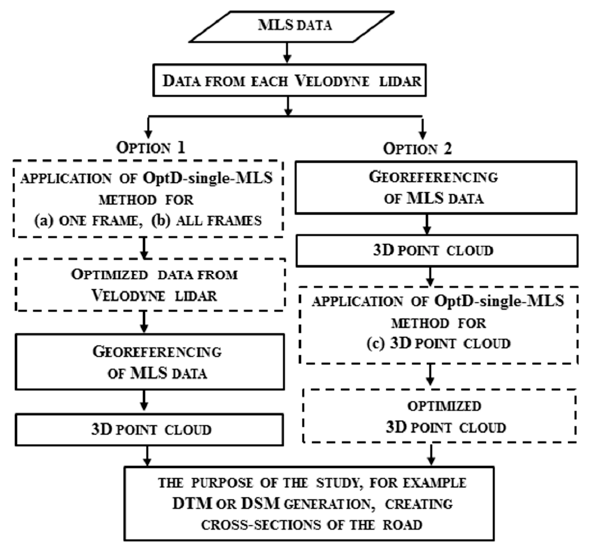
Figure 1. The scheme of Options in step 1 of OptD-single-MLS.